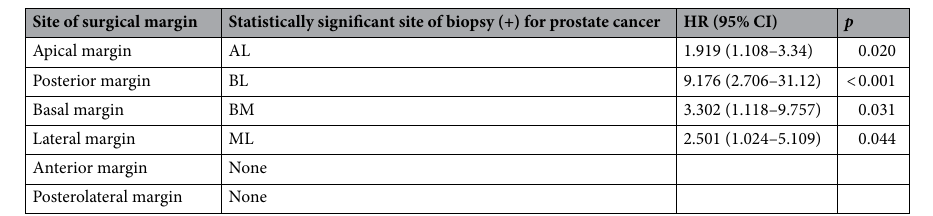
Table 5. The impact of site of positive biopsy for Site-specific surgical margin positivity (Adjusted by BMI, PSA, prostate volume, biopsy Gleason grade). AM apical medial, AL apical lateral, MM middle medial, ML middle lateral, BM basal medial, BL basal